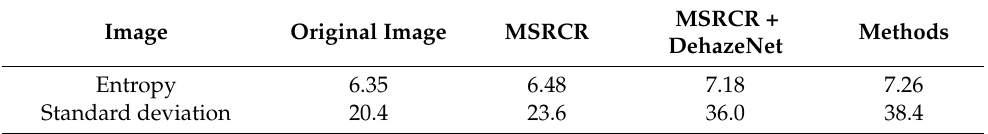
Table 2. Comparison of quantitative results of underwater image enhancement.